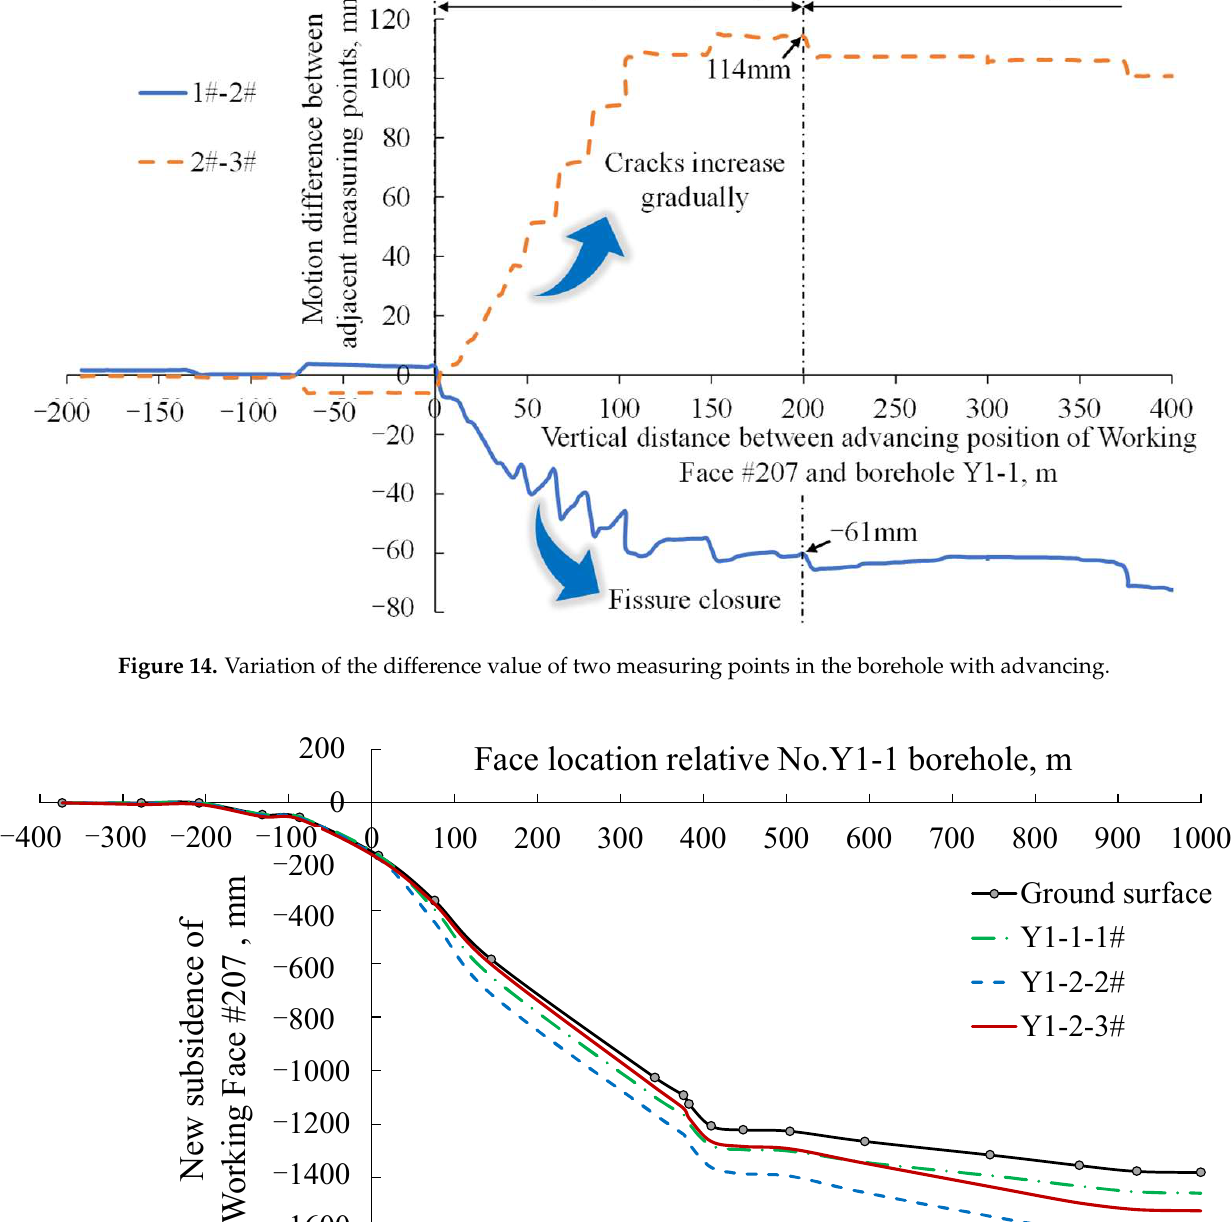
Minerals 2021 , 11 , x FOR PEER REVIEW 19 of 23